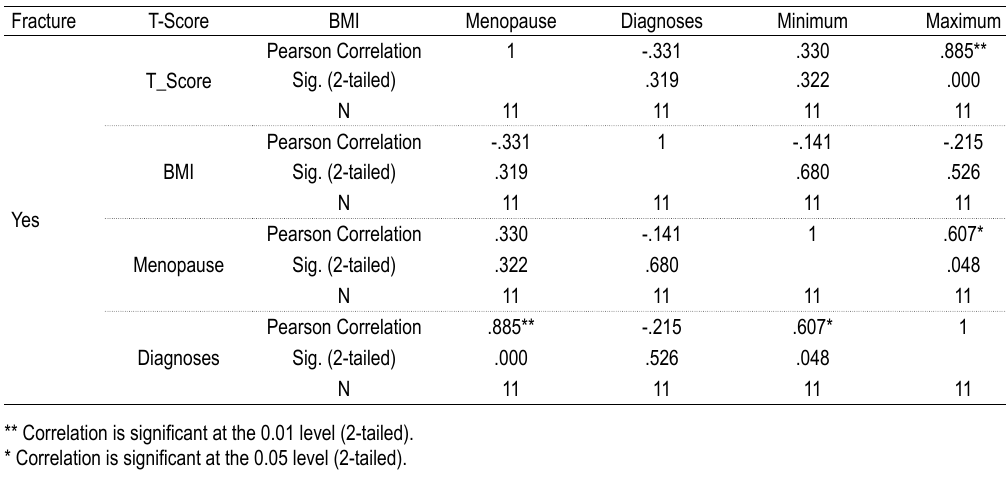
TablE 2. Correlation of frequency of fractures in female respondents in relation to the diagnosis, menopause, and BMI and t-score values